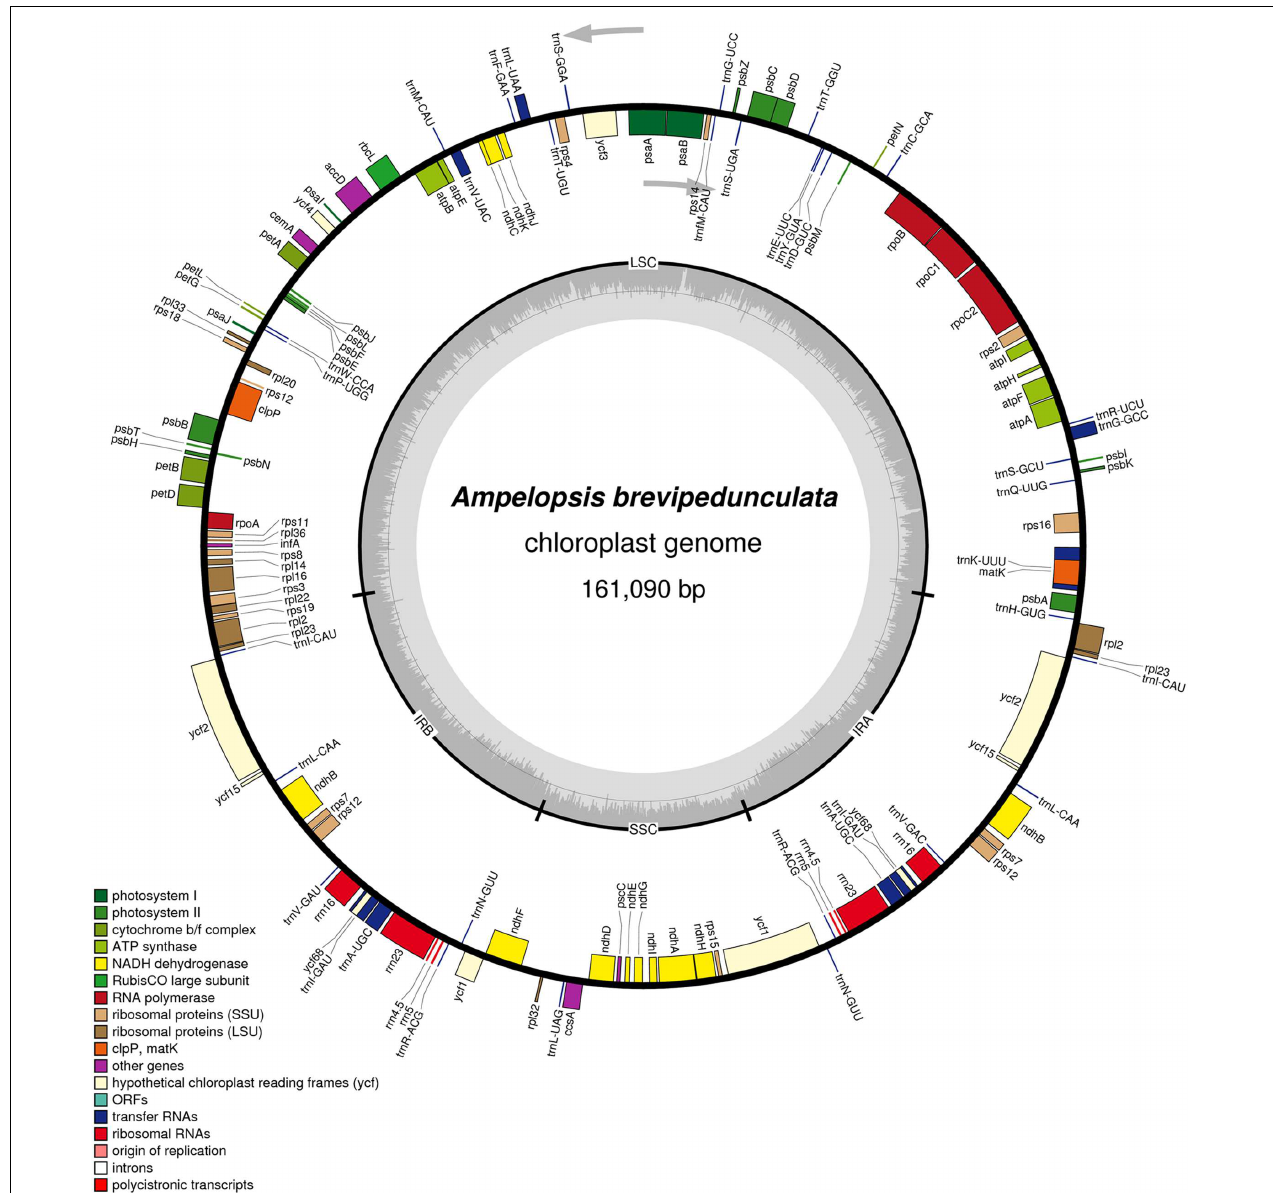
FIGURE 1 | Gene map of the Ampelopsis brevipedunculata . Genes lying outside of the outer layer circle are transcribed in the counterclockwise direction, whereas genes inside of this circle are transcribed in the clockwise direction. The colored bars indicate known protein-coding genes, tRNA genes and rRNA genes. The dashed darker gray area in the inner circle denotes GC content, while the lighter gray area indicates the AT content of the genome. LSC, large-single-copy; SSC, small-single-copy; IR, inverted repeat.